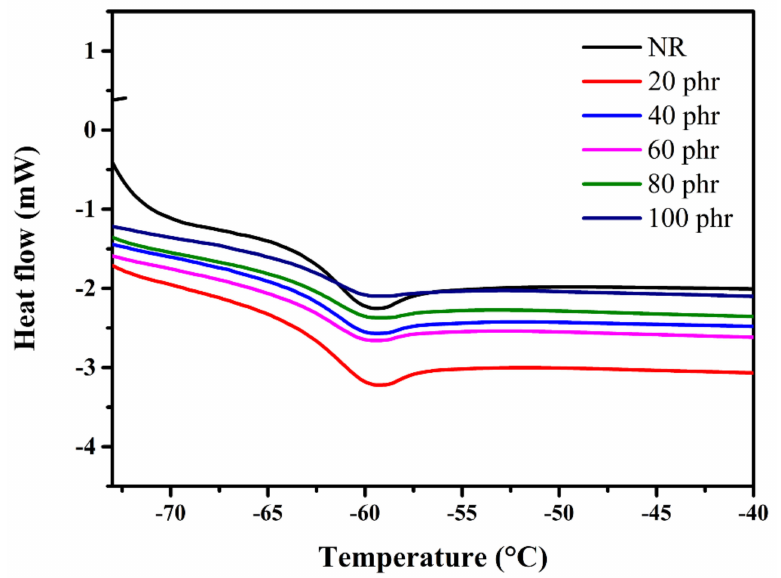
Figure 9. DSC thermogram of silica aerogel/NR composites in different silica aerogel contents and NR